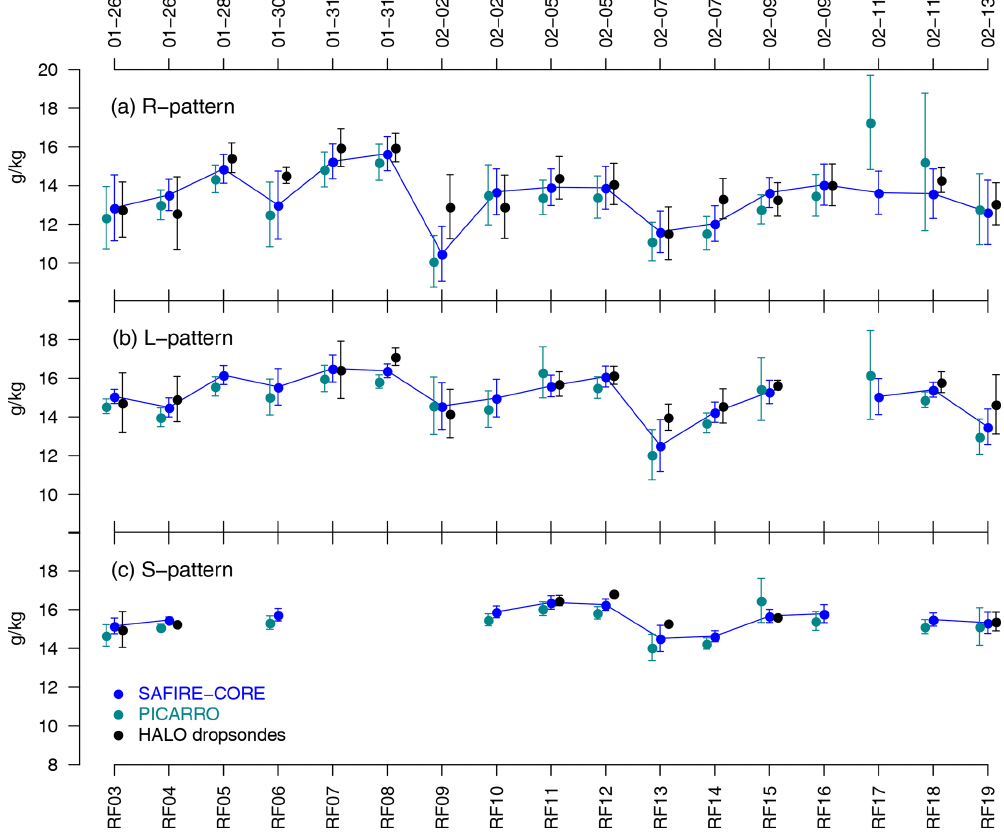
Figure 16. Comparison for each ATR flight of the water vapor mixing ratio inferred (blue) from the SAFIRE-CORE dataset, (turquoise) from the Picarro dataset and (black) from the JOANNE dropsonde dataset. Panels (a) , (b) and (c) are associated with different kinds of ATR patterns: R patterns (flown at cloud base), L patterns (flown in the subcloud layer) and S patterns flown near the sea surface, respectively. Note that the time axis is not linear. For the sake of readability, the markers associated with the different datasets are displayed with a slight horizontal offset. For a given flight, vertical bars represent the standard deviation of the mean values associated with the different segments of the same kind. The standard deviation of dropsonde data is computed on the basis of all the individual dropsondes launched during each ATR